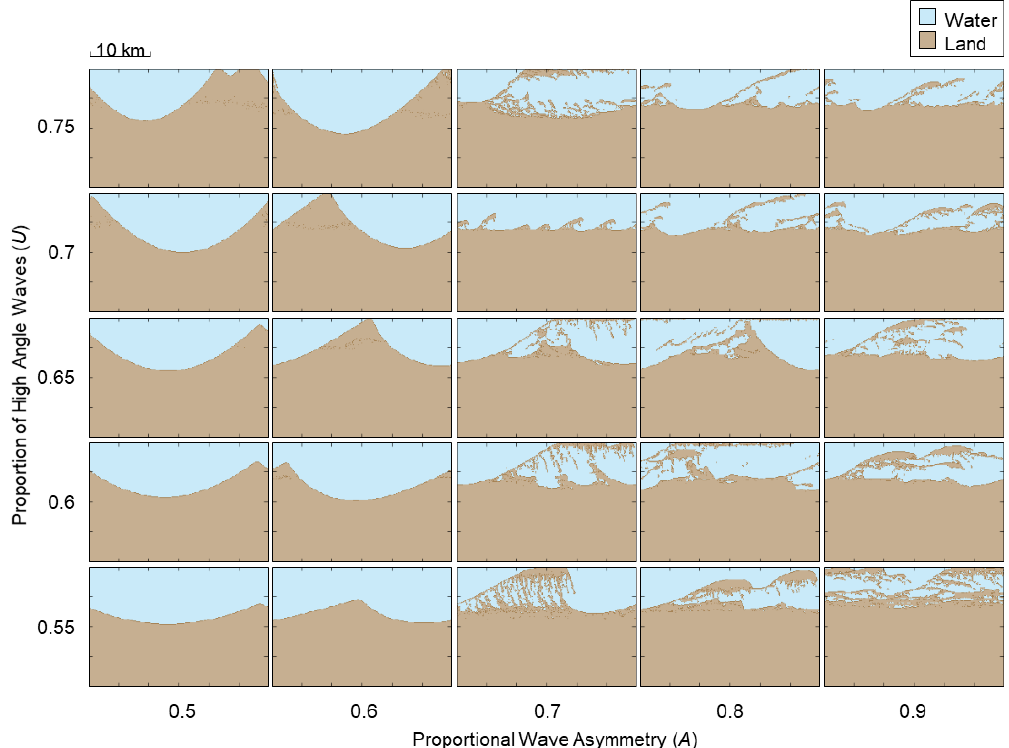
Figure 10. A matrix of results from CEM showing final shoreline morphologies as a function of the wave angle asymmetry ( A ) and proportion of high-angle waves ( U ) approaching the coast relative to the local shoreline orientation. The outputs measure 20km in width and 30km in length and are not inclusive of the periodic